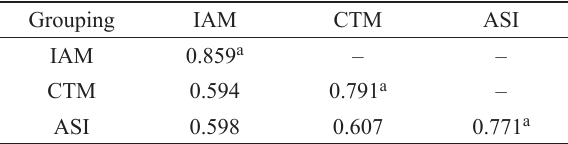
Table 6. Discriminant validity of latent